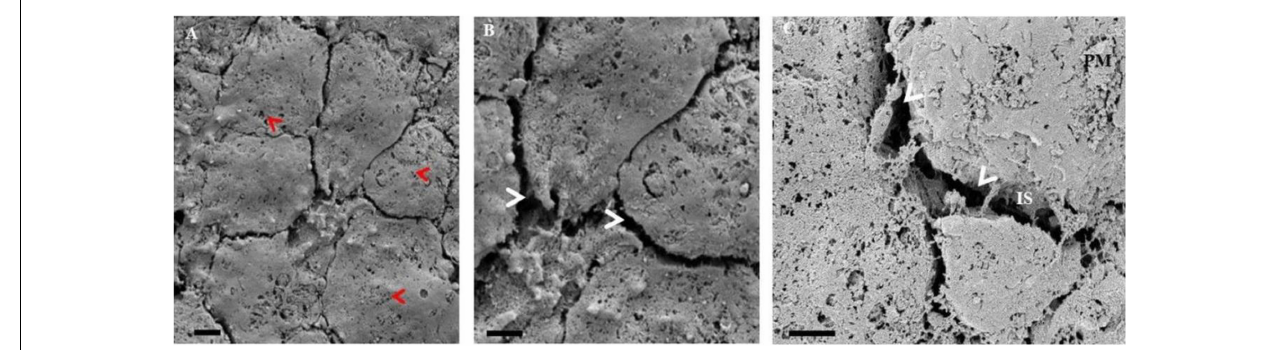
FIGURE 11 | A series of HRSEM micrographs of early stages of the primary rat cardiac microvascular endothelial cell, illustrating the ultrastructural topography of a confluent CMEC monolayer, growing in close proximity. In (A) the “red arrows” indicate the pervasive fenestra on the rat CMECs (Scale bar = 2,000 nm). Furthermore, in (B) apparent, is the conspicuous absence of TENTs and TUNTs and surface NVs. The “white arrows” indicate the multiple intercellular spaces (IS) devoid of NTs and TJ protein-protein interaction (Scale bar = 2,000 nm). In (C) the HRSEM micrograph displays a PC space between CMECs grown in close proximity. The CMEC monolayer is devoid of NVs as indicated by the “white arrows” (Scale bar = 1,000